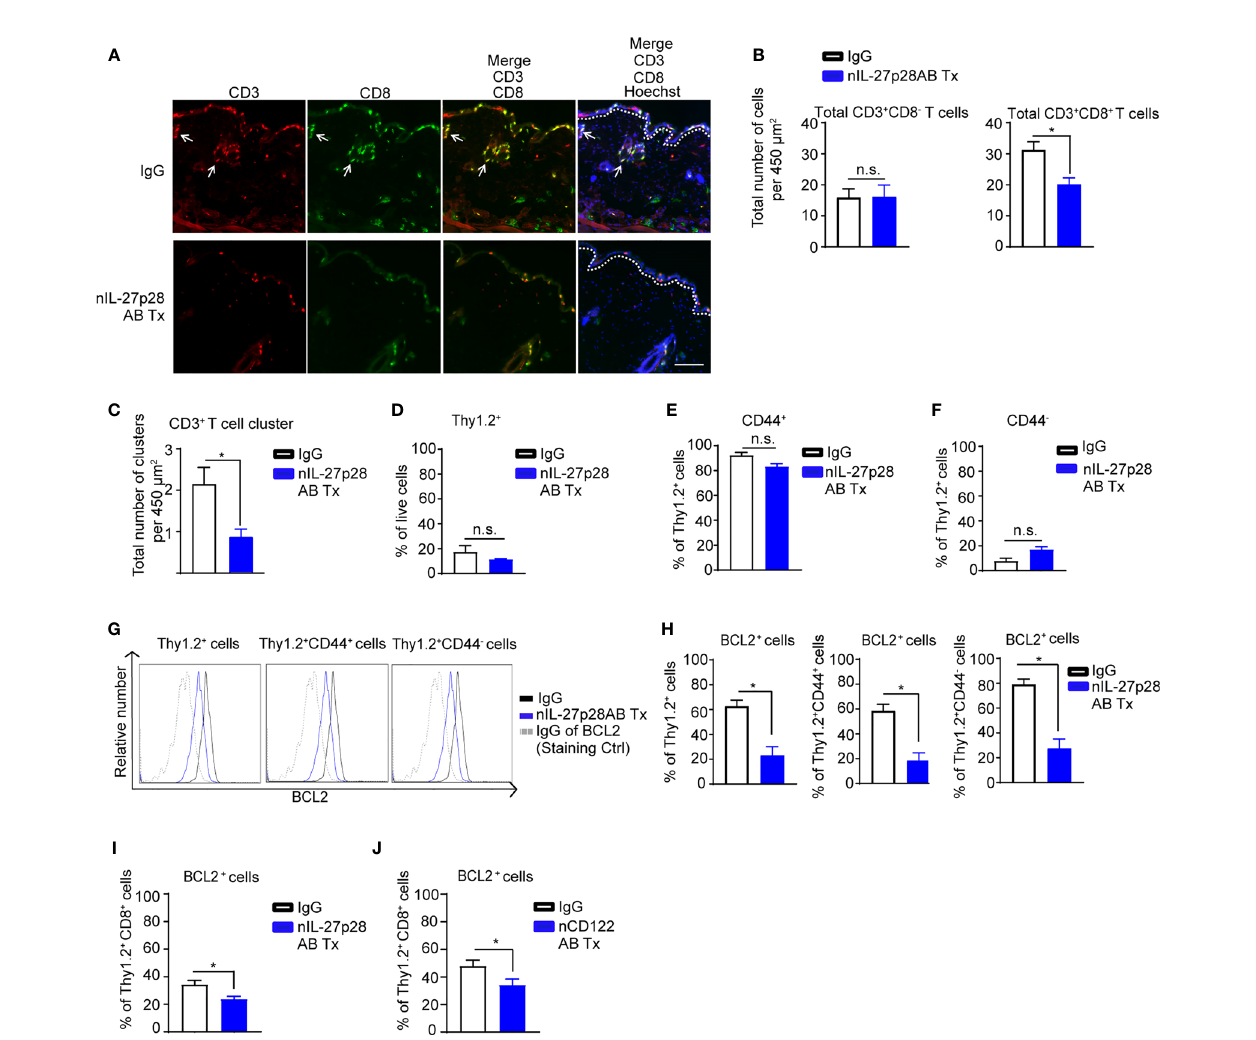
FIGURE 8 | IL-27p28 is required for T cell maintenance post-elicitation. (A) Representative immuno fl uorescence staining showing CD3 (red), CD8 (green), and Hoechst (blue) in back skin from the CHS mice treated with neutralizing IL-27p28 antibody (nIL-27p28AB) or control IgG. The mice started to receive nIL-27p28AB 70 days after elicitation and the mouse skin were harvested 2 days after the fi rst treatment. White arrows indicate leukocyte clusters. Data are representative of 4 mice. Original magni fi cation x200 with scale bars 100 µm. White dashed lines mark the epidermal-dermal junction. (B) Analysis of total numbers of CD3+CD8- and CD3+CD8+ T cells of mouse back skin following nIL-27p28AB treatment. Data are depicted as mean ± SEM from 4 mice per group using at least 3 microscopic views (area = 450 µm 2 ), *p < 0.05; n.s., not signi fi cant (unpaired Student ’ s t test). (C) Analysis depicting total numbers of CD3 + T cell clusters (size of CD3 + cell diameter > 20 µM) of mice back skin upon treatment with nIL-27p28AB (6 µg, 3 times twice a day). Data are depicted as mean ± SEM from 4 mice per group using at least 3 microscopic views (area = 450 µm 2 ), *p < 0.05 (unpaired Student ’ s t test). (D – H) Flow cytometry analysis of repetitive DNFB exposure mouse ear upon injection with nIL-27p28AB (12 µg) or IgG vehicle control for 2 days showing mean frequency ± SEM of total (D) Thy1.2 + cell and (E) CD44 + and (F) CD44 - cells in Thy1.2 + cells. Representative (G) histogram and (H) frequency of BCL2 that are gated on Thy1.2 + , Thy1.2+CD44 + , or Thy1.2 + CD44 - cells. Data are depicted